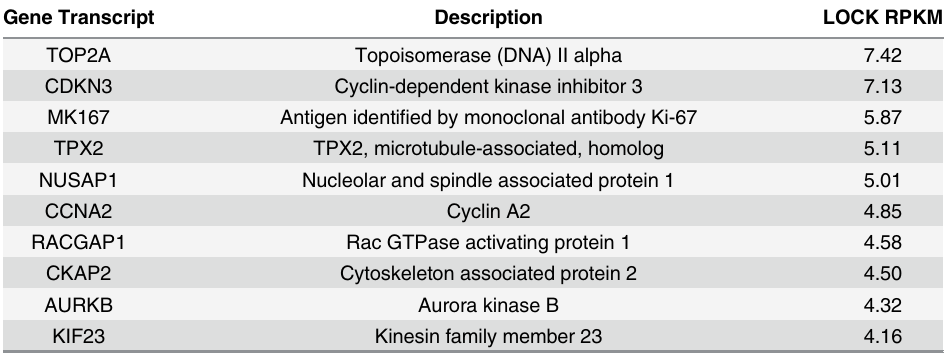
Table 5. Top 10 genes expressed in LOCK but not RUN, sorted by average